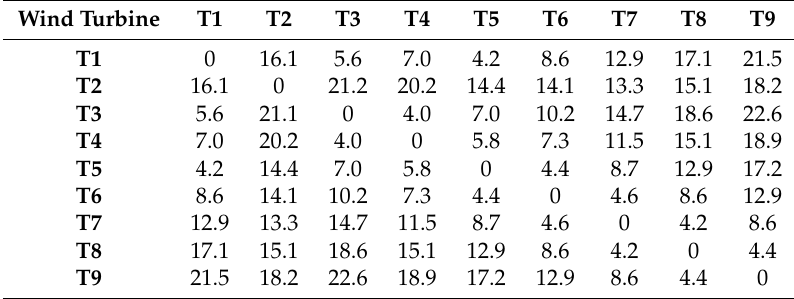
Table 1. Inter-turbine distances in rotor diameters.